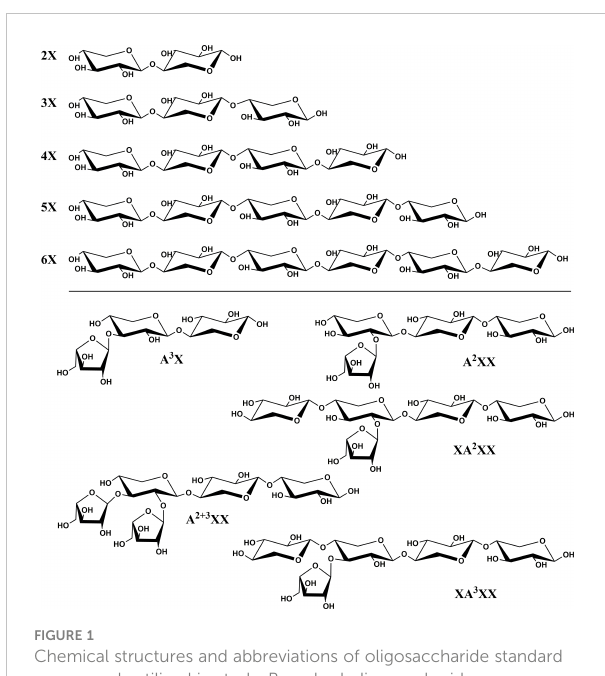
FIGURE 1 Chemical structures and abbreviations of oligosaccharide standard compounds utilized in study. Branched oligosaccharides were named following the system proposed by Faure ́ et al.